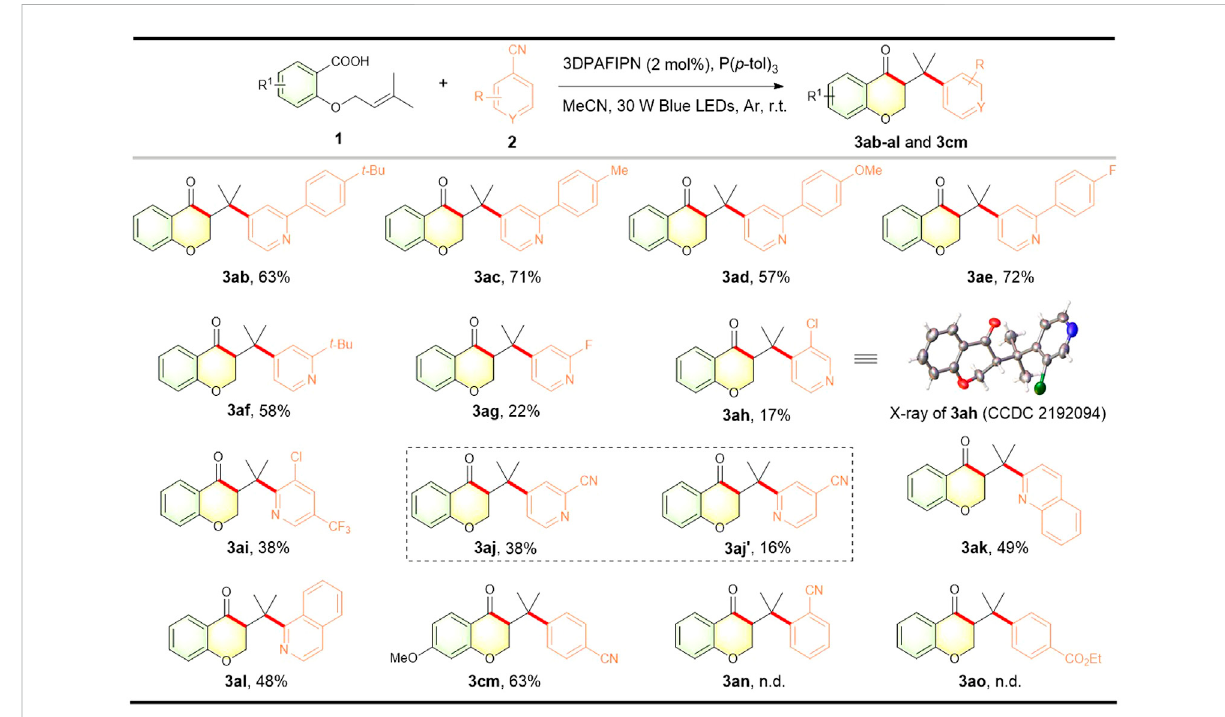
FIGURE 3 Scope of cyano (hetero)arenes. Reaction conditions: 1 (0.3 mmol), 2 (0.45 mmol), 3DPAFIPN (2 mol%), P ( p -tol) 3 (0.6 mmol), MeCN (6 ml), 30 W blue LEDs, argon atmosphere, r.t., 24 h. The isolated yield is based on 1 .